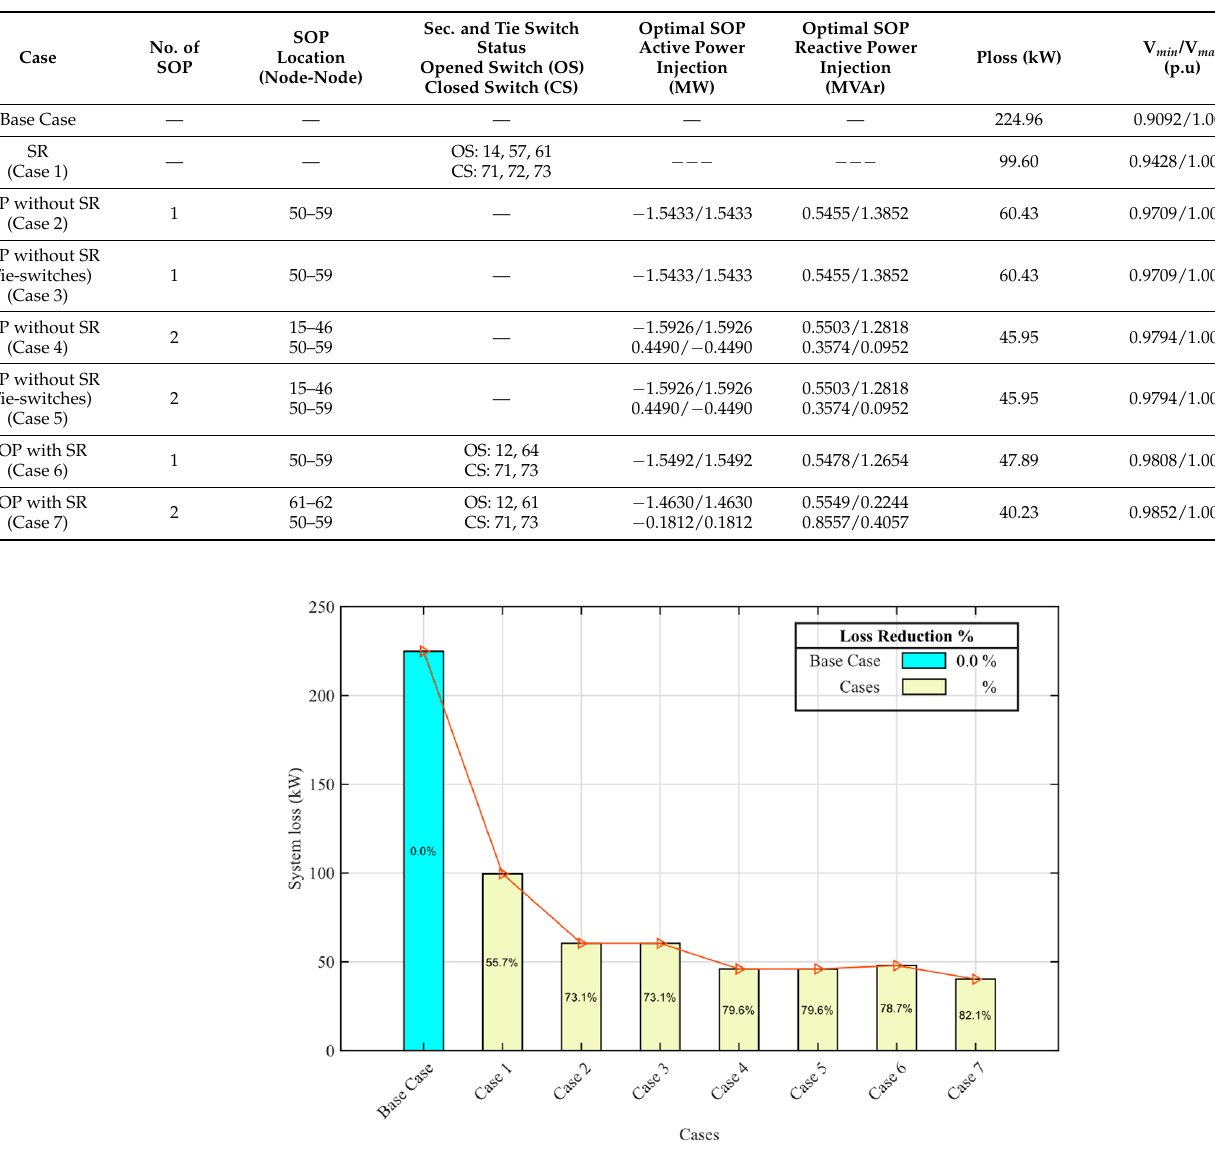
Figure 10. Voltage magnitude profile of the 69-node test DS for all cases.